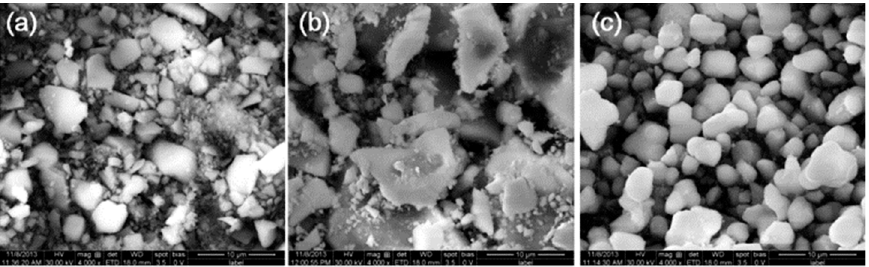
Figure 2. FE-SEM images of LiNi, ( a ) citric acid (LiNi-C); ( b ) L-ascorbic acid (LiNi-A); and ( c ) sorbitol Figure 2. FE ‐ SEM images of LiNi, ( a ) citric acid (LiNi ‐ C); ( b ) L ‐ ascorbic acid (LiNi ‐ A); and ( c ) sorbi ‐ tol (LiNi ‐ S) [30]. (LiNi-S)